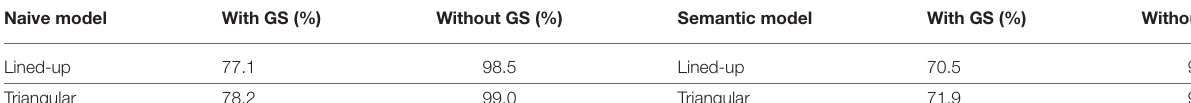
TABLE 2 | Predictability for the naive and semantic GHMM models with and without the grasping state feature. Naive model